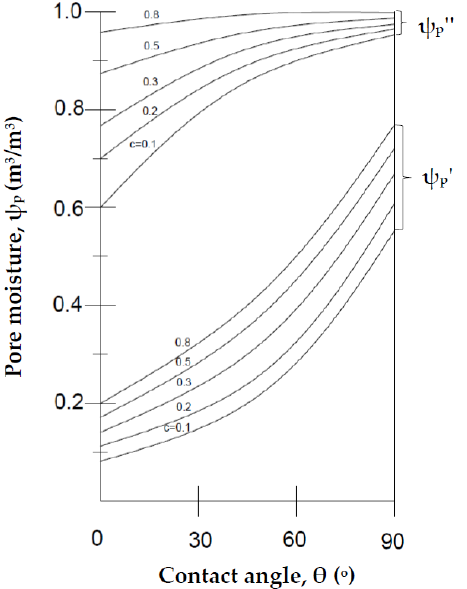
Figure 3. Dependence of the boundary pore moisture ψ p ʹ and ψ p ʹʹ on the contact angle θ and relative dimension of the bar with a square cross section c = Δ/L = f (m 1 ).